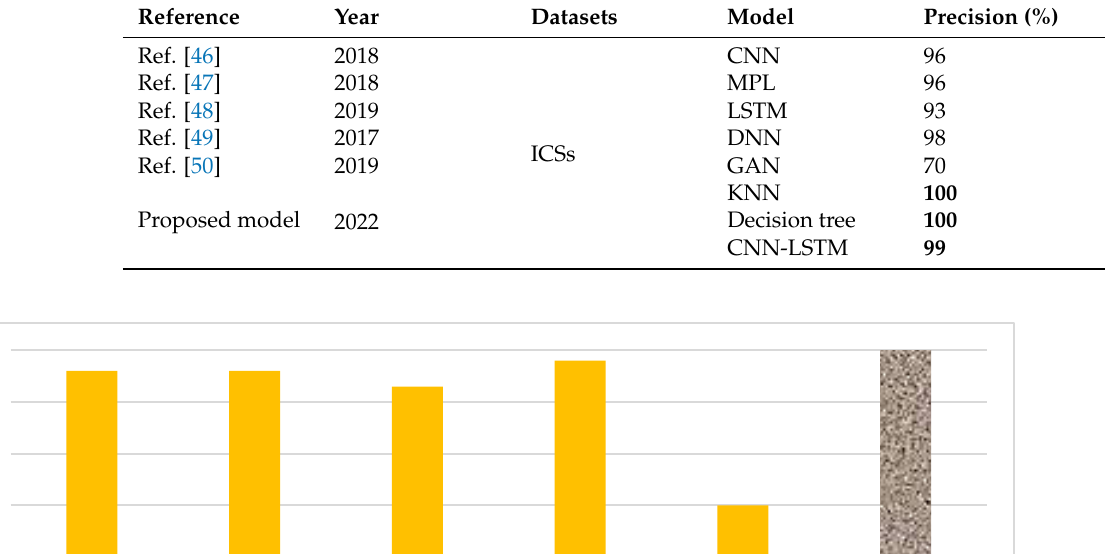
Table 16. Comparison of the proposed system to existing systems using different ICS datasets.